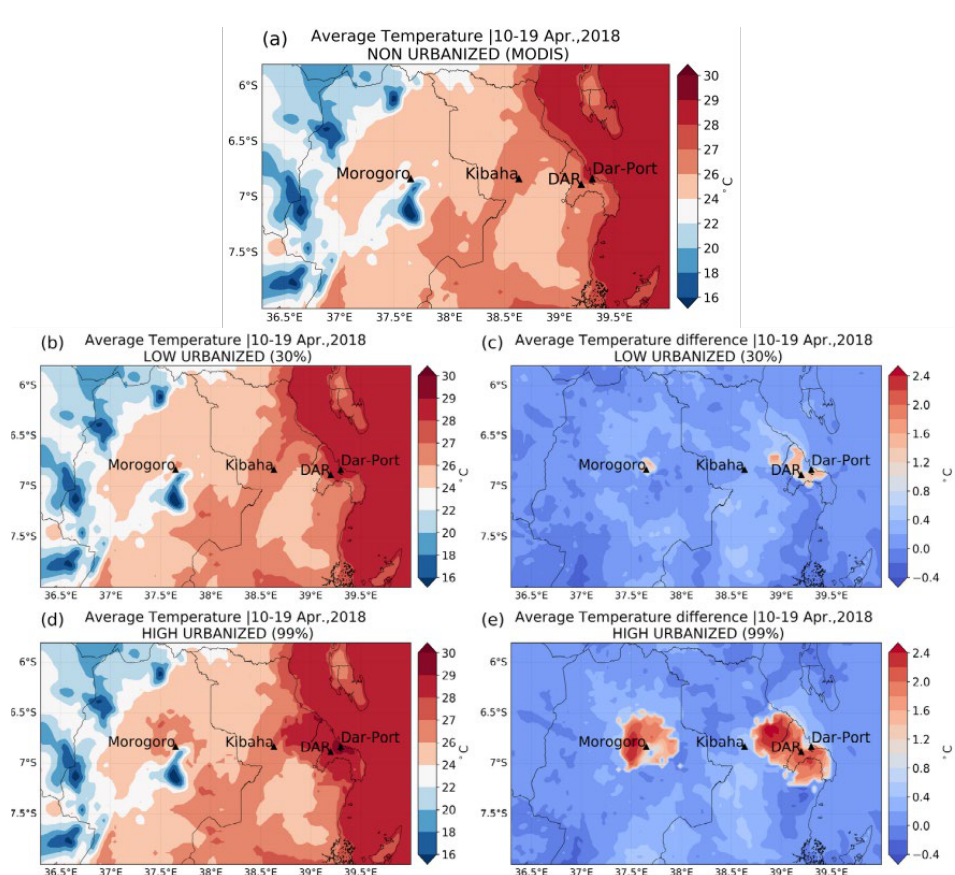
Figure 7. Spatial distribution of period averaged near surface air temperature for ( a ) current LULC, ( b ) low-urbanization, and ( d ) high-urbanization scenarios, and their differences (urbanized–current) between the current LULC and ( c ) low urbanized and ( e ) high urbanized scenarios.